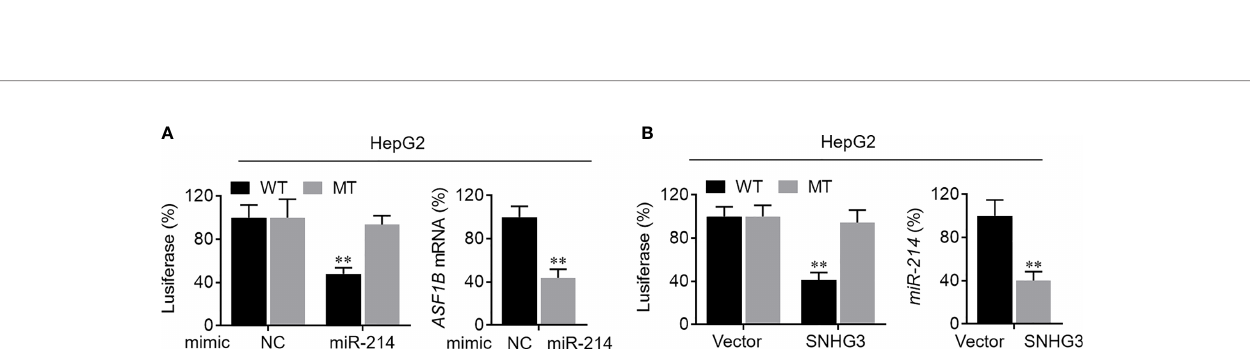
FIGURE 8 | Veri fi cation of SNHG3-miR-213-3p-ASF1B regulatory axis. (A) Left: the regulatory relationship between ASF1B and miR-214-3p was validated in luciferase reporter assay; right: the mRNA level of ASF1B in HepG2 cells was markedly downregulated by miR-214-3p overexpression. (B) Left: the regulatory relationship between lncRNA SNHG3 and miR-214-3p was validated in luciferase reporter assay; right: the mRNA level of miR-214-3p in HepG2 cells was signi fi cantly decreased by SNHG3 overexpression. **p <